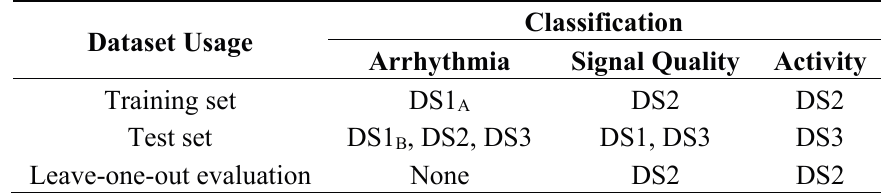
Table 8. Dataset usage for classification evaluation.